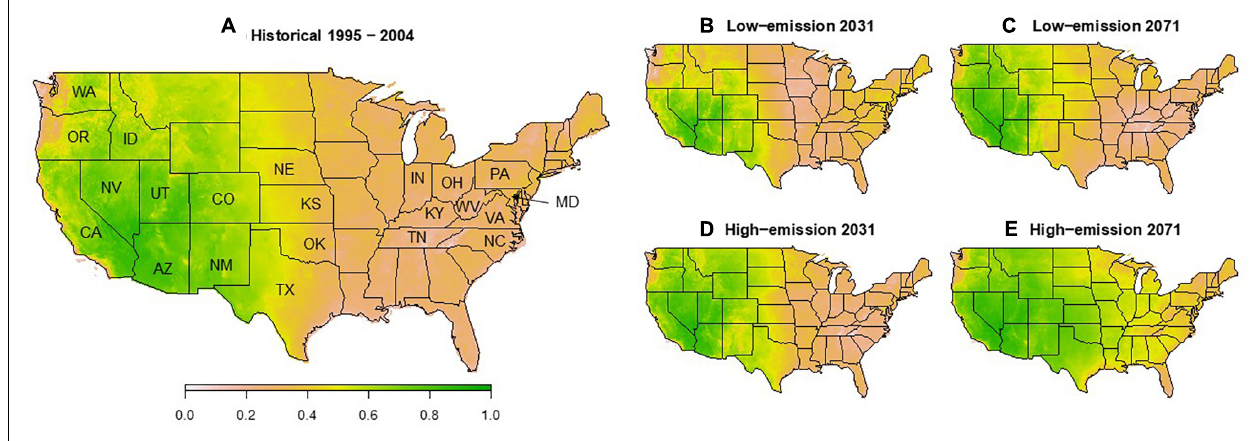
FIGURE 3 | Annotated map of regions and States of the United States referred to in the text and modeled survival of G. morbida as a function of equilibrium moisture content (EMC) for average historical (A) and future low- ( B,C , RCP4.5) and high-emission ( D,E , RCP8.5) climate scenarios 20 (B,D) and 50 years (C,E) into the future. Survival for each year was obtained by multiplying monthly survival estimates from a logistic regression fit to results from Experiment 4 for May through September. For historical survival (A) , yearly survival estimates were averaged across the 10-year timespan. Monthly average EMC was calculated using the model of Glass and Zelinka (2010) as a function of monthly average temperature and humidity averaged from Multivariate Constructed Analogs (MACA) statistical downscaling method, Version 2 (Abatzoglou, 2013) and Geophysical Fluids Dynamic Laboratory Earth System Models II (GFDL-ESM2M) under the Representative Concentration Pathway scenarios (IPCC,